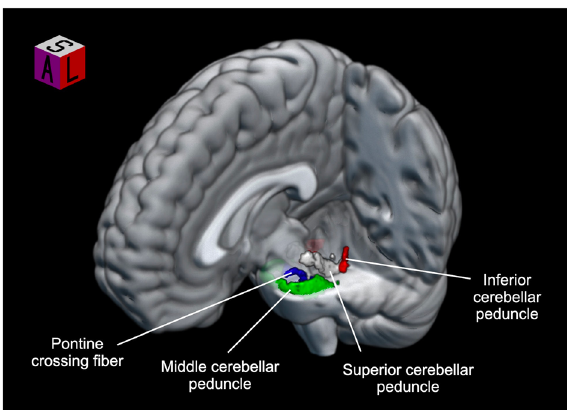
Fig. 1 White matter regions of interest. Major white matter bundles connecting the cerebellum to other central nervous system were chosen based on the JHU DTI-based white matter atlas. The region-of-interest mask was created by multiplying the mean FA skeleton mask with the regional mask of the cerebellar